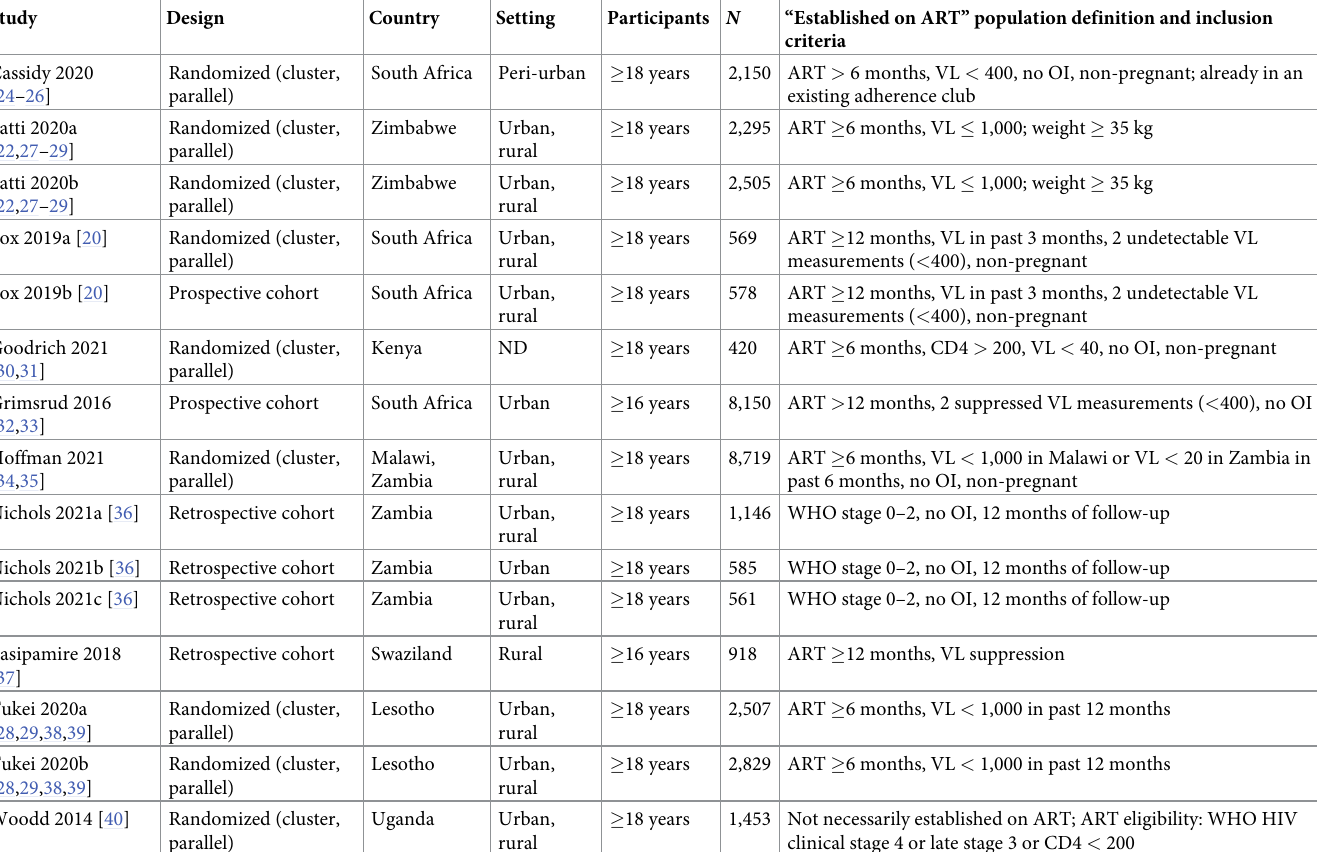
Table 2. Summary of included